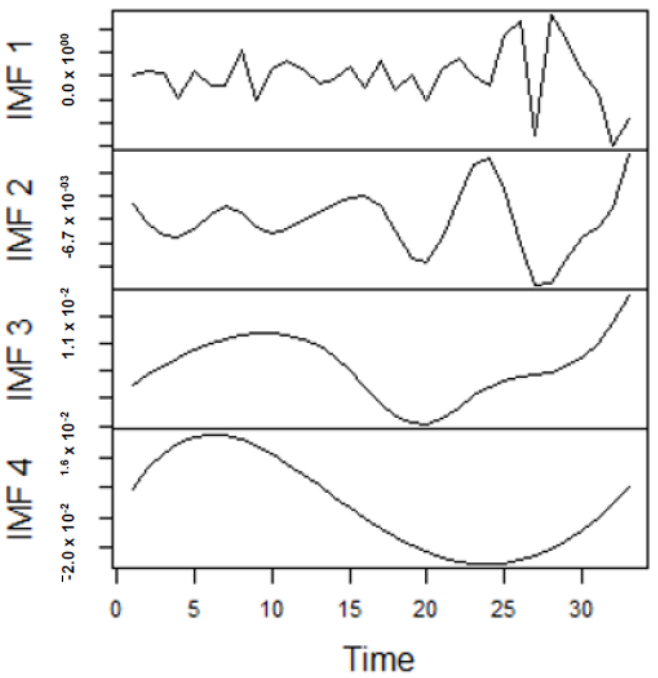
Figure 9. Panel A: Part of the IMFs for Japan gas prices in normal